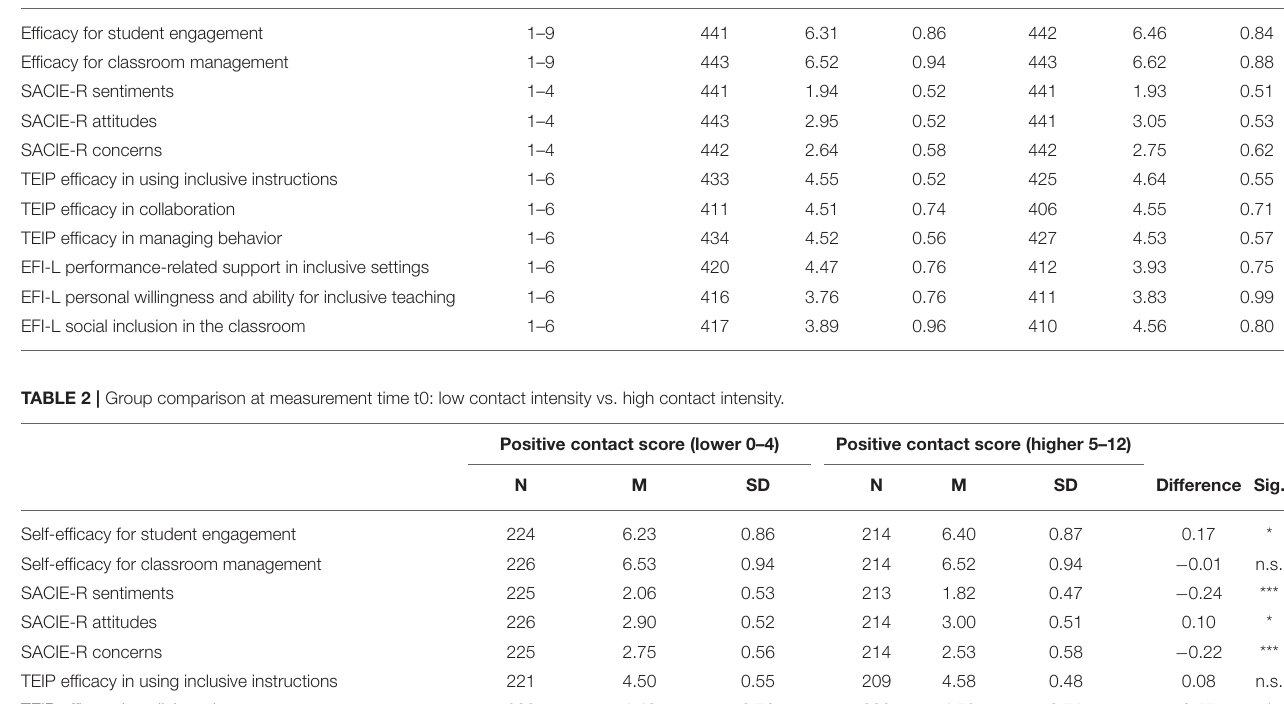
TABLE 1 | Mean values of the relevant scales at the time of measurement t0 and t1 ( N = 443). Scales t0/t1 Rating scale